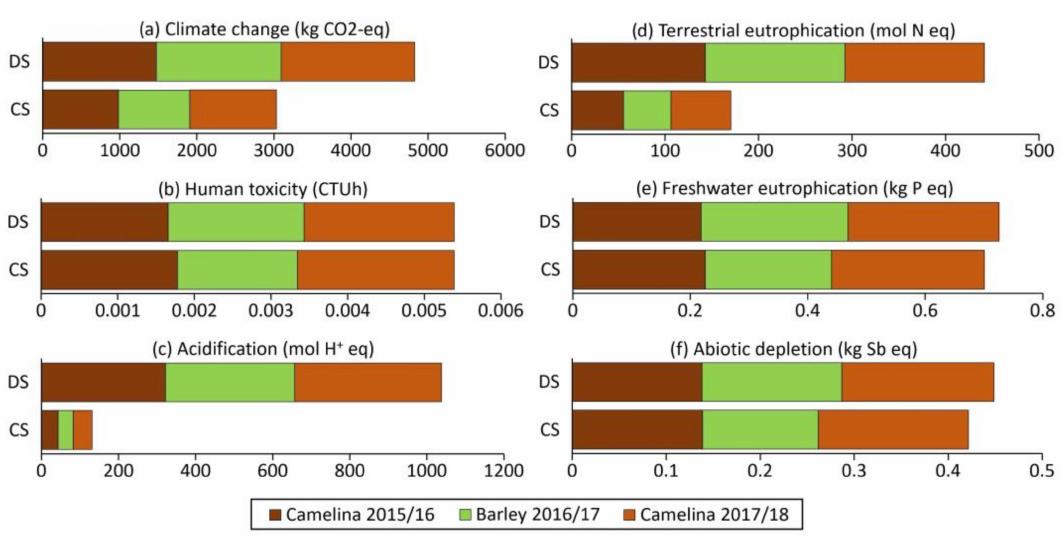
Figure 4. Environmental impact categories comparison ( a – f ) concerning the cultivation of the crop rotation camelina-barley- camelina fertilized with dewatered sludge (DS) and composted sludge (CS).